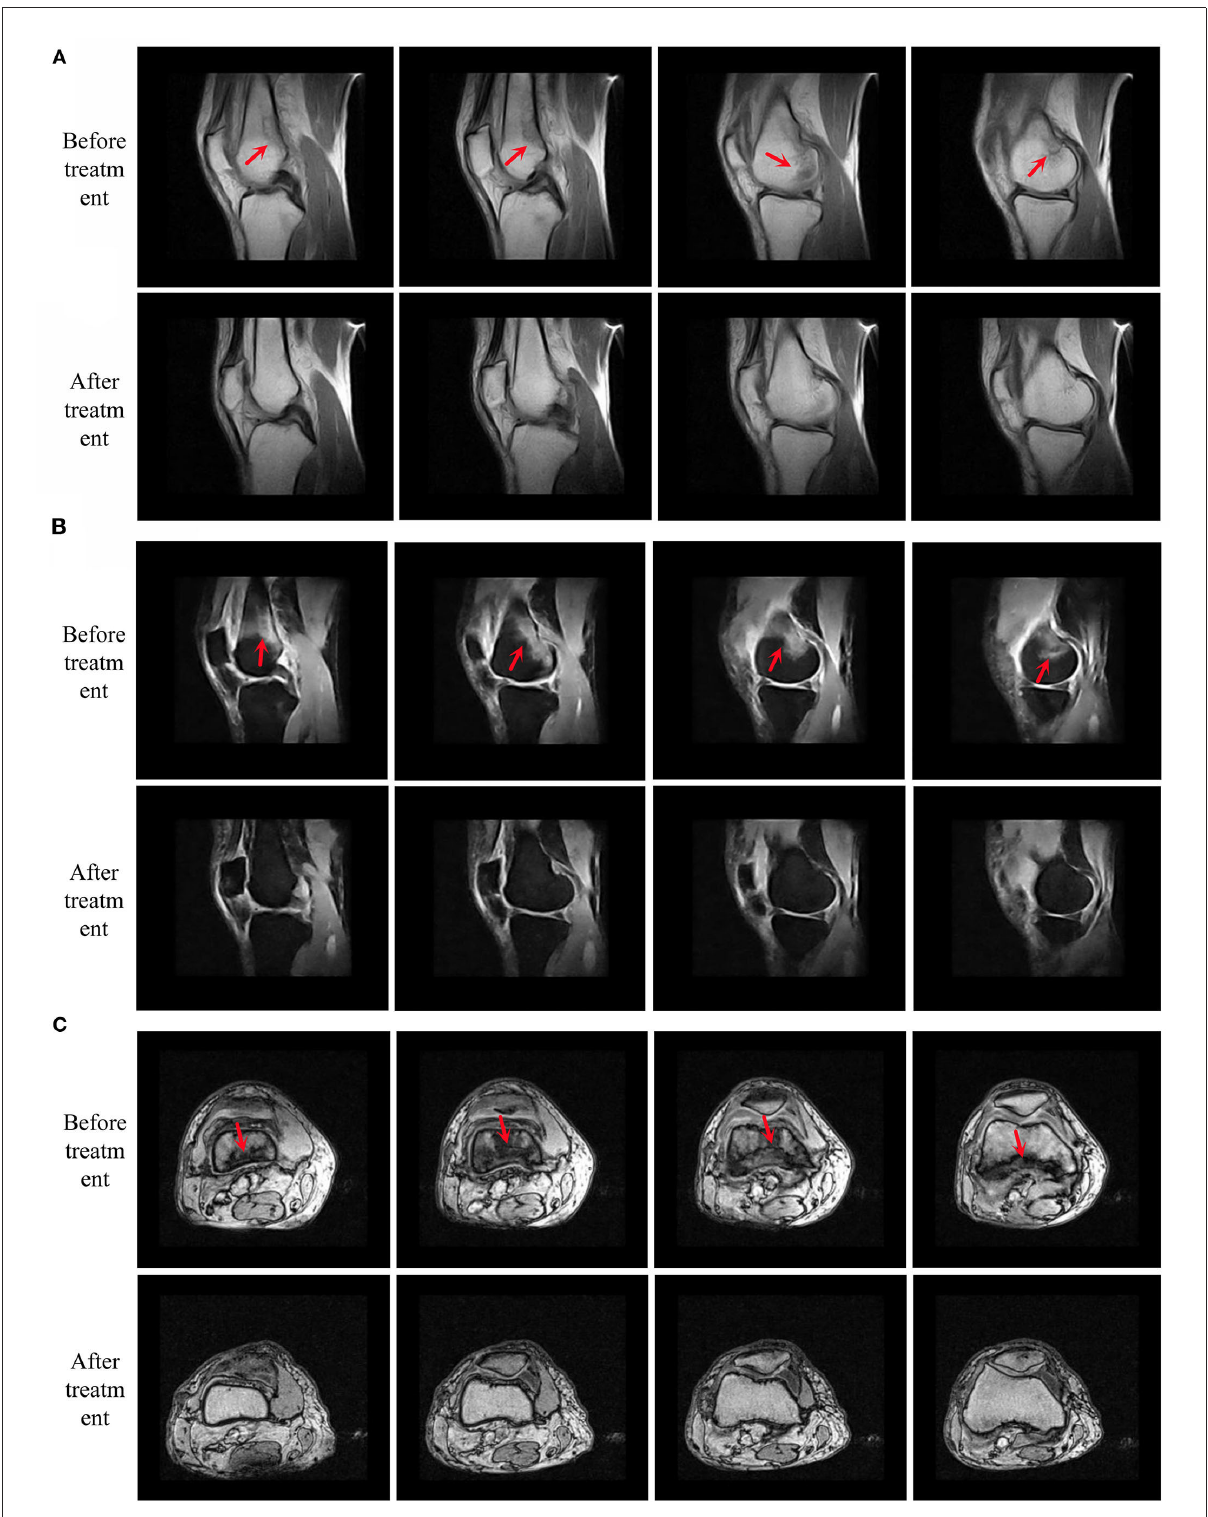
FIGURE2 MRIs compared before and after treatment. Present four consecutive magnetic resonance images from left to right. (A) Sagittal conventional sequence. (B) Sagittal fat-suppressed sequence and (C) axial sequence. Serious bone marrow edema-like lesions (the red arrow). MRI, magnetic resonance